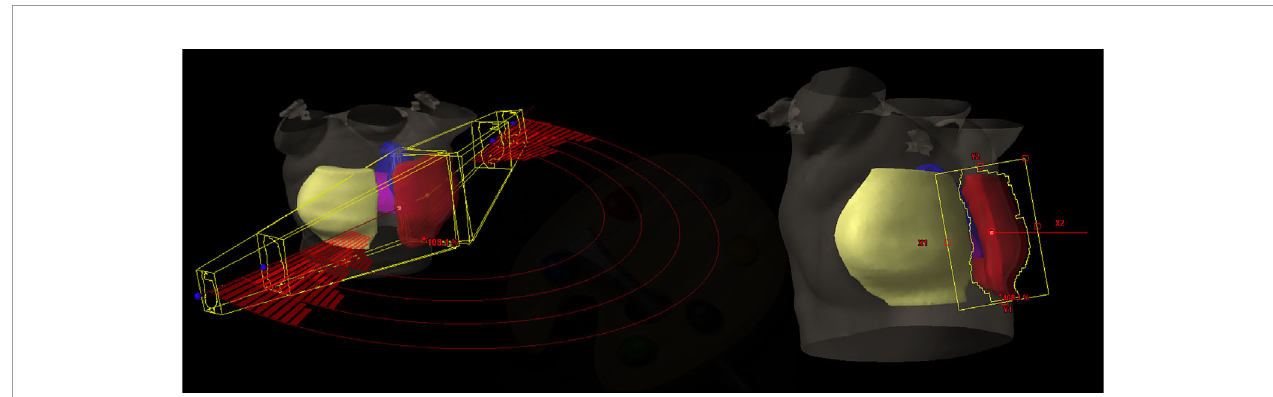
FIGURE 1 | ViTAT setup: 3D view of a right side ViTAT plan showing the geometry of the four arcs used (on the left) — the segments show the beam delivery while the rest of the arcs are blocked for delivery; beam eye view of the medial angle (on the